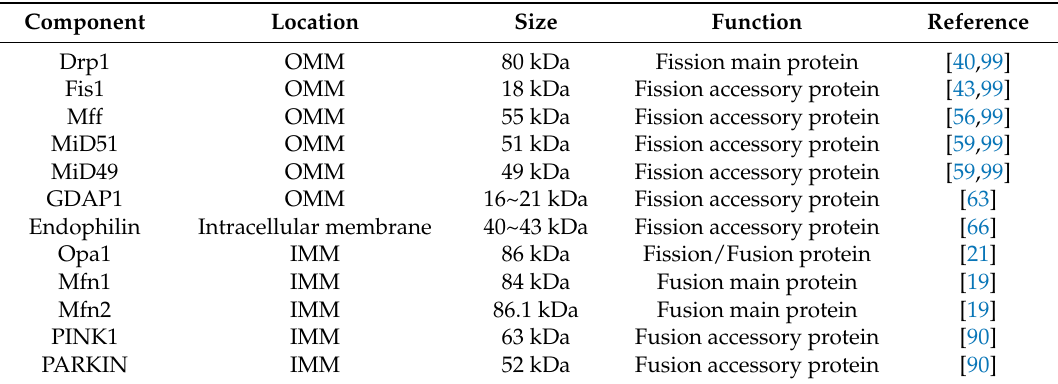
Table 1. Mammalian mitochondrial fission/fusion